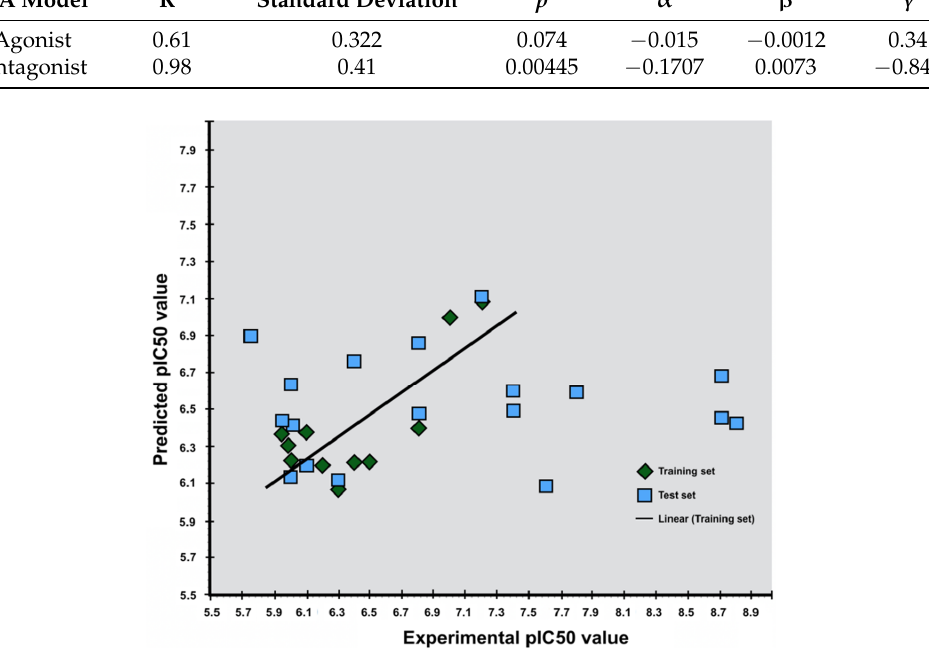
Table 2. The statistical values and LIA parameters ( α , β and γ ) of the LIA models for agonists and antagonists.